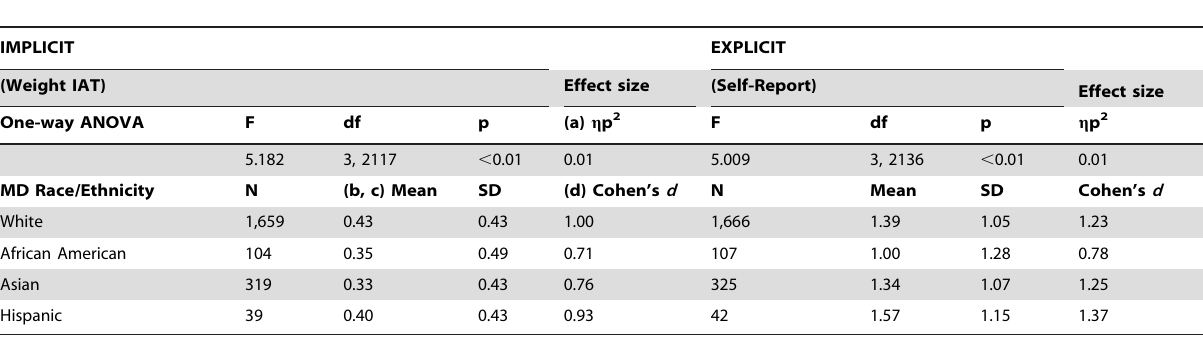
Table 5. Implicit and Explicit Weight Attitude Measures for MDs (medical doctors) by Race and Ethnicity Category.